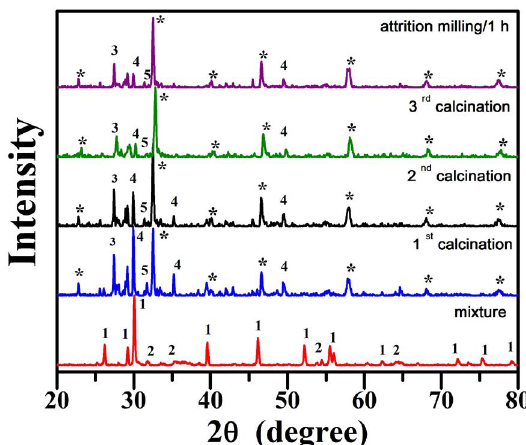
Figure 1. XRD patterns of the starting powder mixture and after calcination (1250 ºC for 4 h) and attrition milling. 1 - La O , 2 3 2 - Ga O , 3 - La Ga O , 4 - LaSrGa O and 5 - LaSrGaO . The 2 3 4 2 9 3 7 4 orthorhombic phase of LSGM is indicated by *. FEG-SEM micrographs of (a) as-prepared LSGM, (b) 8YSZ commercial powder and (c) 8YSZ with 20 wt.% LSGM are depicted in Figure 2. The LSGM powder (Figure 2a) prepared by solid state reaction is characterized by agglomerated particles of irregular shape. Commercial 8YSZ (Figure 2b) are spherical granules resulting from the spray drying process in the production route. The mixture of 8YSZ and LSGM (Figure 2c) consists of porous agglomerates, their size increasing with increasing 8YSZ content. These agglomerates seems to be soft, they break during the conformation step, leading to high density pellets after sintering at 1450ºC, as summarized in Table 1. The relative density of pure LSGM sintered at 1350ºC is 93.5%. In contrast, for higher sintering temperatures the density is 99%. The relative density of compound electrolytes decreases for increasing 8YSZ addition. At 1450ºC, the density is near full for all pellets except for those with 20 wt.% 8YSZ. The density of common impurity phases was not taken into account in these calculations, because their total amount is relatively low. Hereafter only results on pellets sintered at 1450ºC will be shown. XRD patterns of as-sintered pellets are shown in Figure 3. The plots on the left exhibit the entire angular range of XRD measurements, whereas those on the right are enlarged views of the 24-32º range, where the main diffraction peaks of impurity phases are detected. 8YSZ and LSGM display the characteristic cubic fluorite-type and orthorhombic perovskite-type crystalline structures, respectively. Surprisingly, addition of 8YSZ to LSGM promotes phase stabilization, and for 10 wt.% addition, the XRD pattern resembles that of a single phase material. Increasing the fraction of 8YSZ to 20 wt.% a new phase attributed to lanthanum zirconate, La Zr O with pyrochlore structure was 2 2 7 detected revealing a strong interaction among the individual elements of the compound